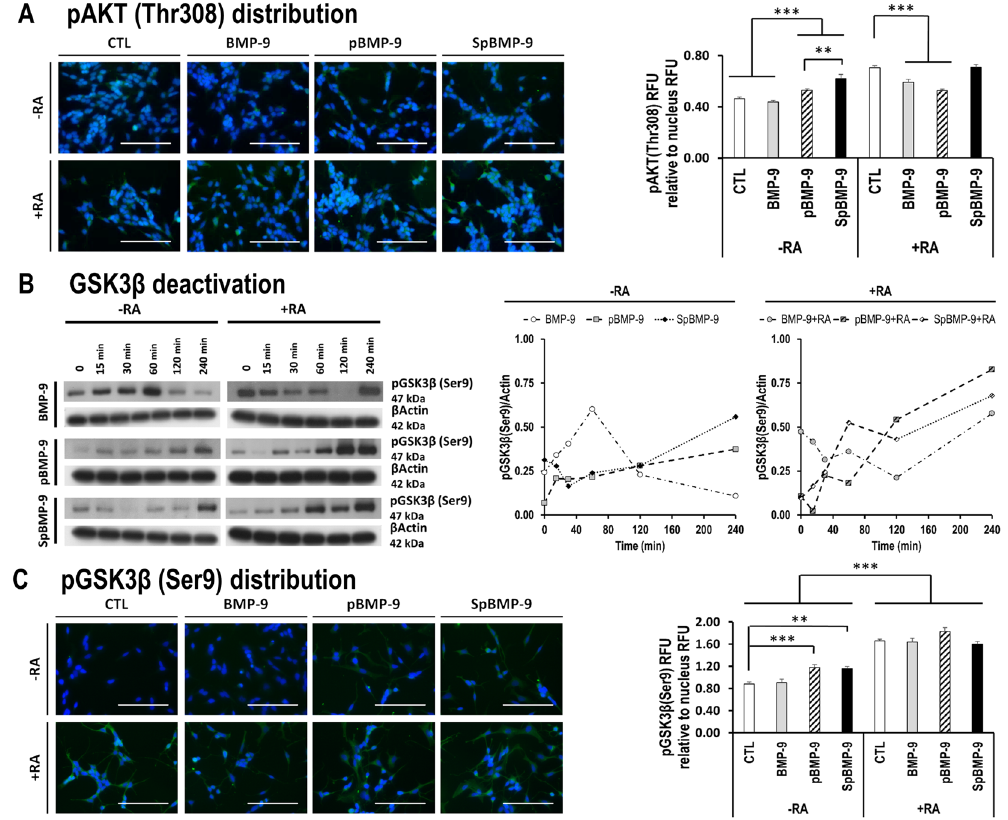
Figure 8. Effect of pBMP-9 and SpBMP-9 on the PI3K/Akt/GSK3 β pathway. ( A ) Merged pictures representative of at least 2 independent experiments showing immunostaining for pAkt (Thr308) (green) and nuclei (Hoechst, blue) of SH-SY5Y cells stimulated for 2 h with 0.1 nM BMP-9, pBMP-9 and SpBMP-9 + / − 10 μ M RA (Bar = 100 μ m) and pAkt(Thr308) fluorescence activity relative to the nucleus. ( B) Western blots of phosphorylated GSK3 β at Ser9 (pGSK3 β ) and densitometric analysis of pGSK3 β bands standardized by actin showing the effect of 0.1 nM BMP-9, pBMP-9 and SpBMP-9 + / − 10 μ M RA in SH-SY5Y cells after incubation for 0, 15, 30, 60, 120 and 240 min. Only cropped pictures of western blots were shown in order to allow a better comparison between experimental conditions. Complete gel pictures are available in the supplementary data file. ( C) Merged pictures representative of at least 2 independent experiments showing immunostaining for pGSK3 β (Ser9) (FITC, green) and nuclei (Hoechst, blue) in SH-SY5Y cells stimulated for 4 h with 0.1 nM BMP- 9, pBMP-9 and SpBMP-9 + / − 10 μ M RA (Bar = 100 μ m). Analysis of pGSK3 β (Ser9) fluorescence intensity relative to the nucleus staining was also presented. Results are the means ± SEM ( ** p < 0.01, *** p <